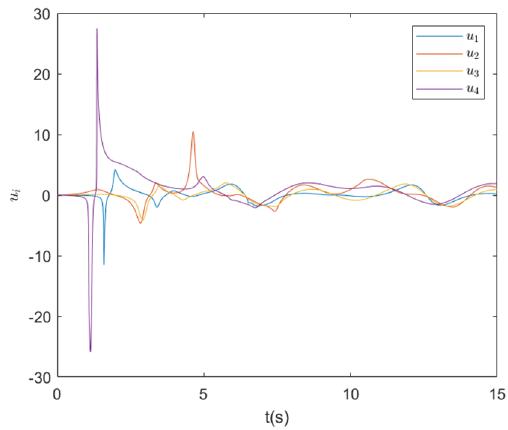
Figure 3. Outputs Figure 3. Outputs x i ,1 for 1 ≤ i ≤ 4 and y d .